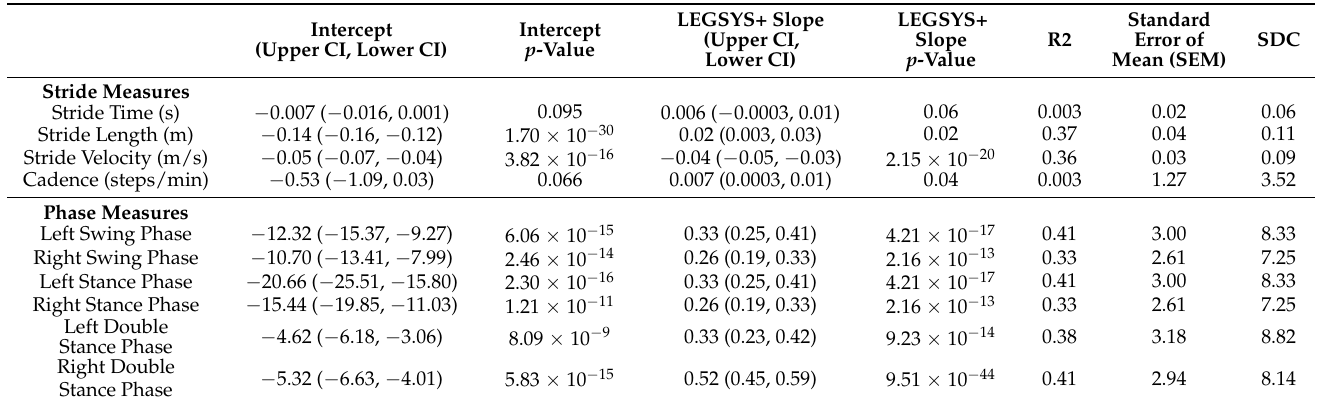
Table 3. Bland altman linear regression